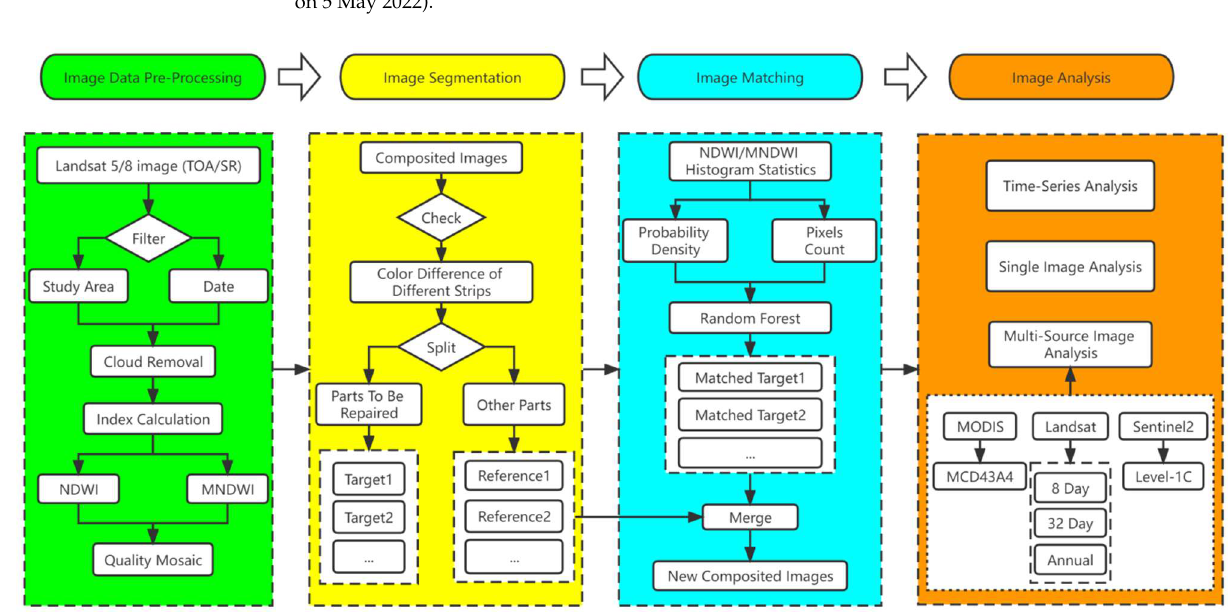
Figure 2. Overall methodology of the study.